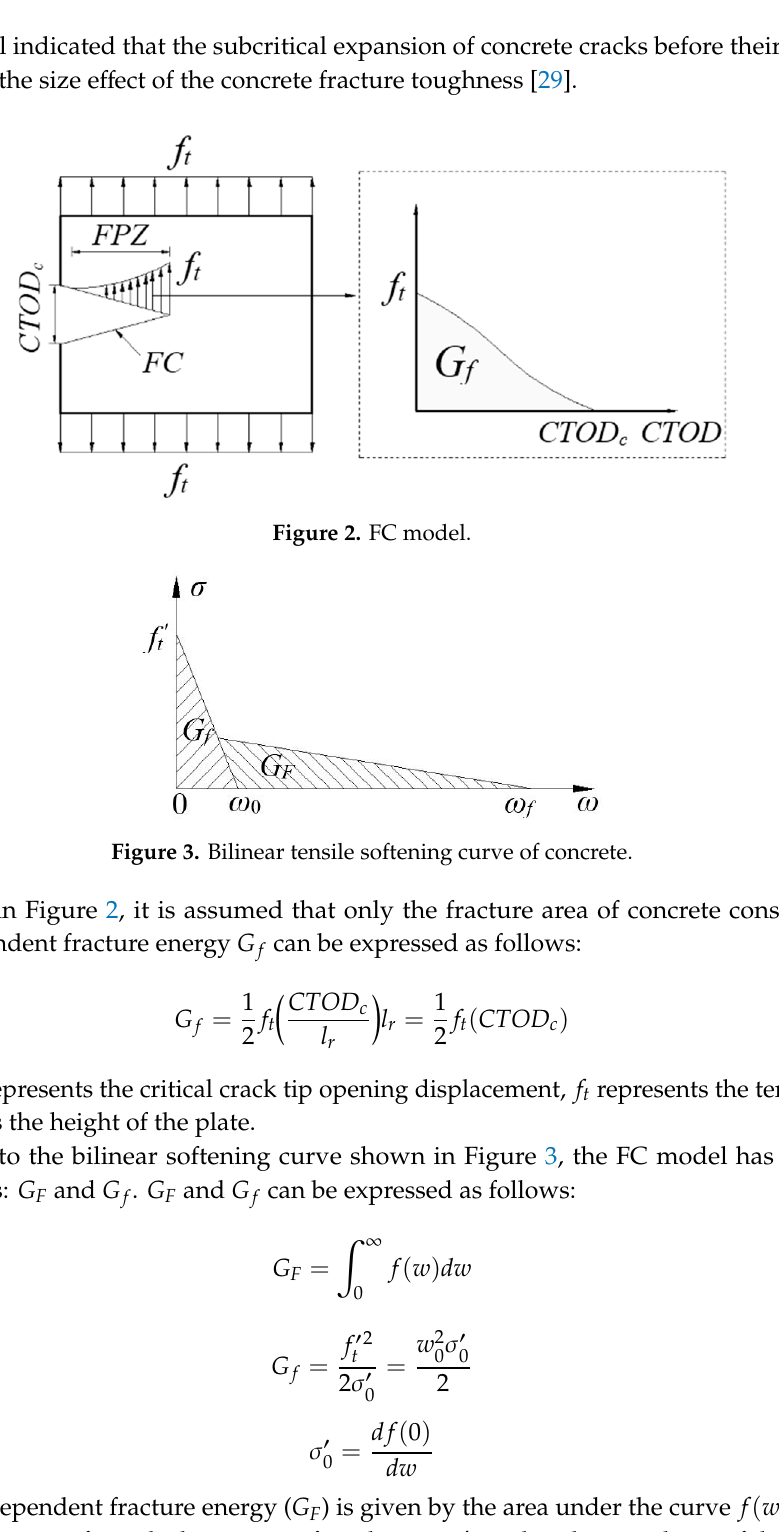
Materials 2020 , 13 , x FOR PEER REVIEW